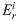
Cumulative probability curves of Eri for each heavy metal in the surface sediments of western Laizhou Bay.Eri is the potential ecological risk factor of substance ‘‘i”, and the green dotted line represents Eri = 40. Cumulative probability curves of Eri on the left side of this straight line indicate low risk.